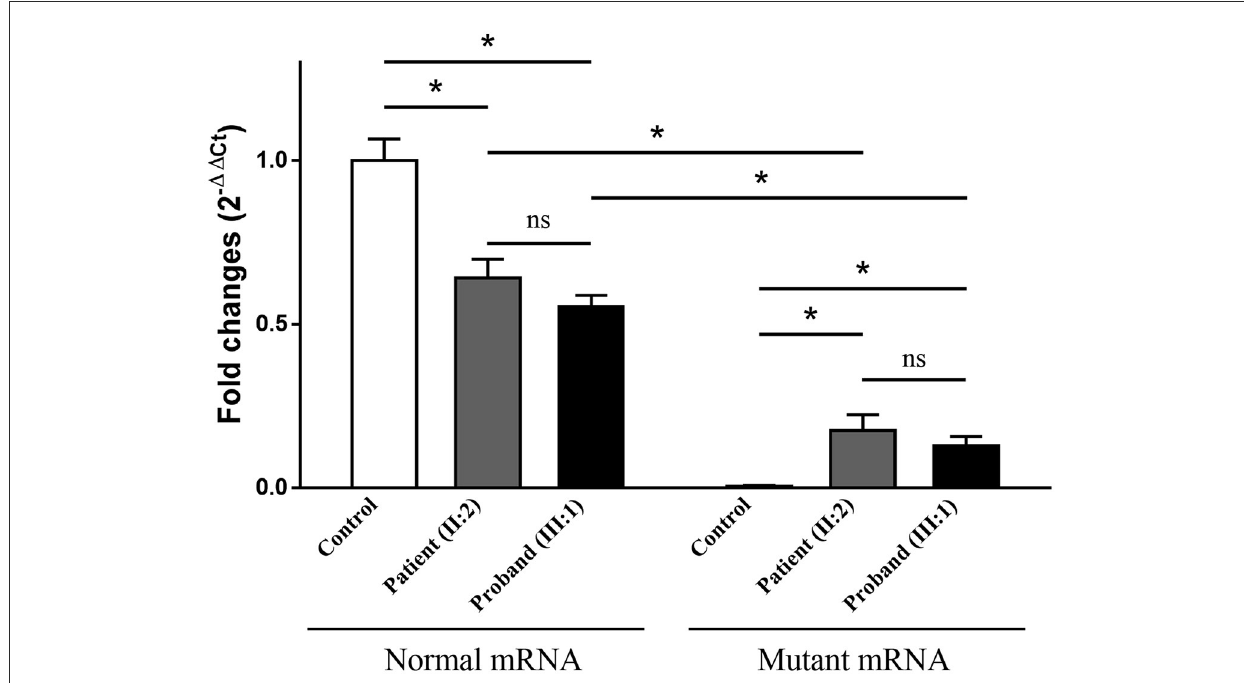
FIGURE5 The relative levels of mRNA of the TSC2 gene, normalized to the average normal mRNA level of controls (ns: not significant, * P <